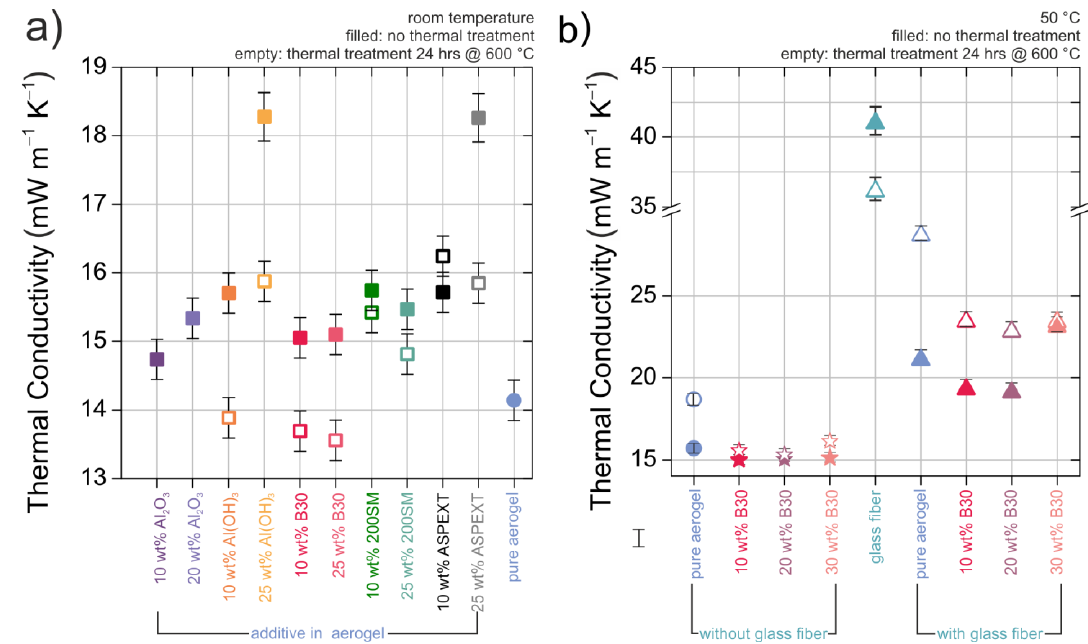
Figure 2. ( a ) Thermal conductivity of the pure silica aerogels (dots) (the thermal conductivity of the pure silica aerogels synthesized at room temperature (RT) could not be determined due to the fact of its decomposition into several fragments after heat treatment at 600 °C) and SAs combined with different ceramic (the silica–aerogel with the ceramic Al 2 O 3 particles could not be measured after heat treatment, because the material broke into several pieces ) opacifiers and various amounts of them before (filled squares) and after heat treatment (unfilled squares) synthesized at room temperature. ( b ) Thermal conductivity of the pure silica aerogels (dot) and SAs combined with different ceramic opacifiers and various amounts of them before (filled triangles) and after heat treatment (unfilled triangles) synthesized at 50 °C (all measured via Hot Disk method).